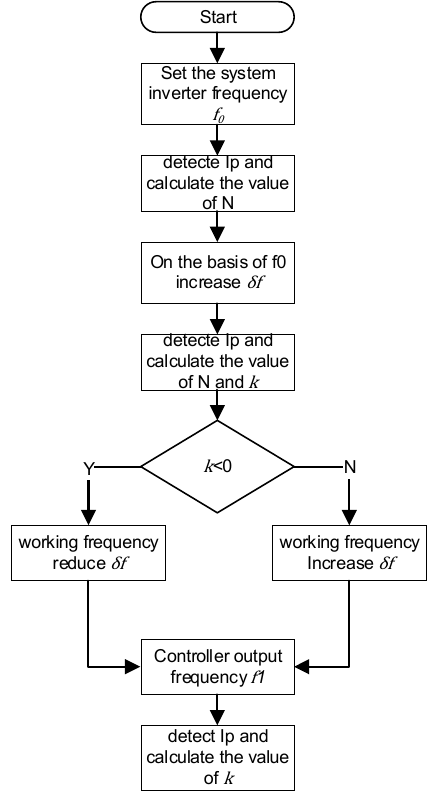
Figure 8. Resonant frequency control flow chart based on inverter current RMS.